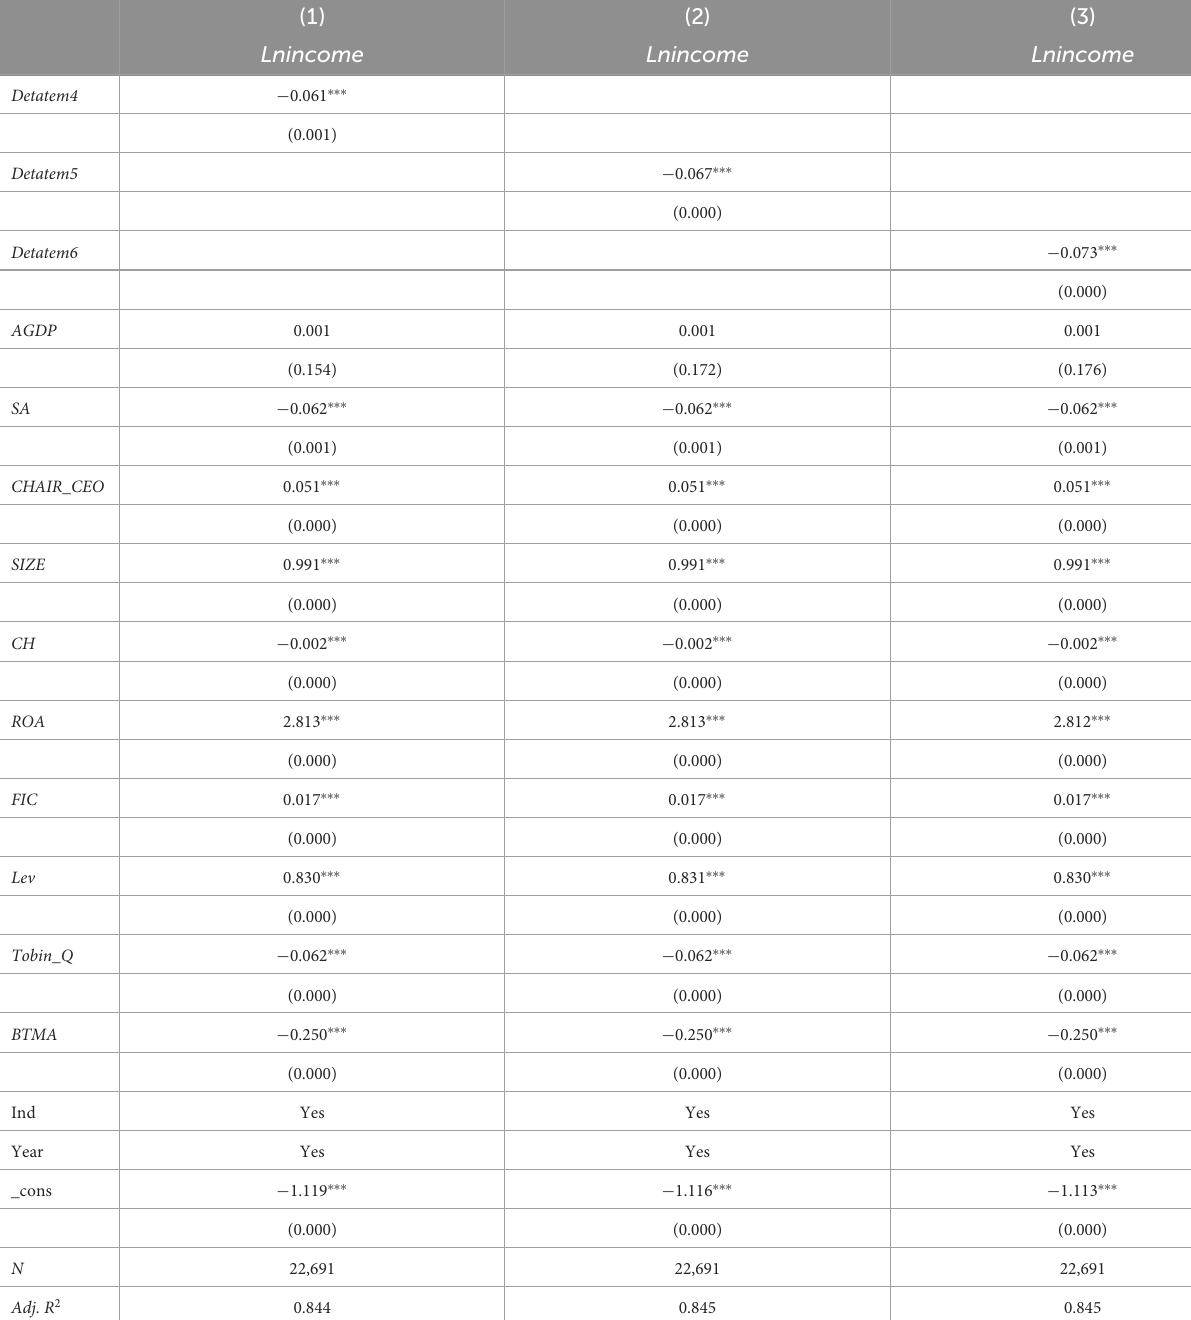
TABLE 7 Impact of temperature variation difference on sales